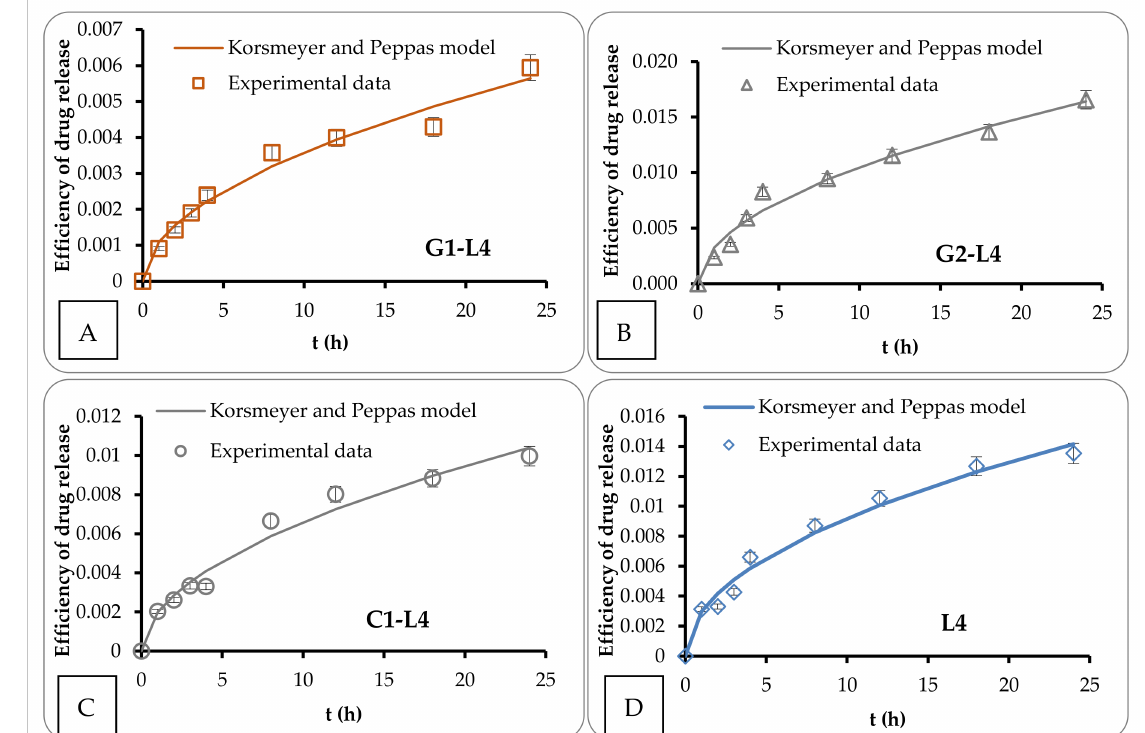
Figure 4. The theoretical and experimental release profiles for G1–L4 ( A ), G2–L4 ( B ), C1–L4 ( C ) and L4 ( D